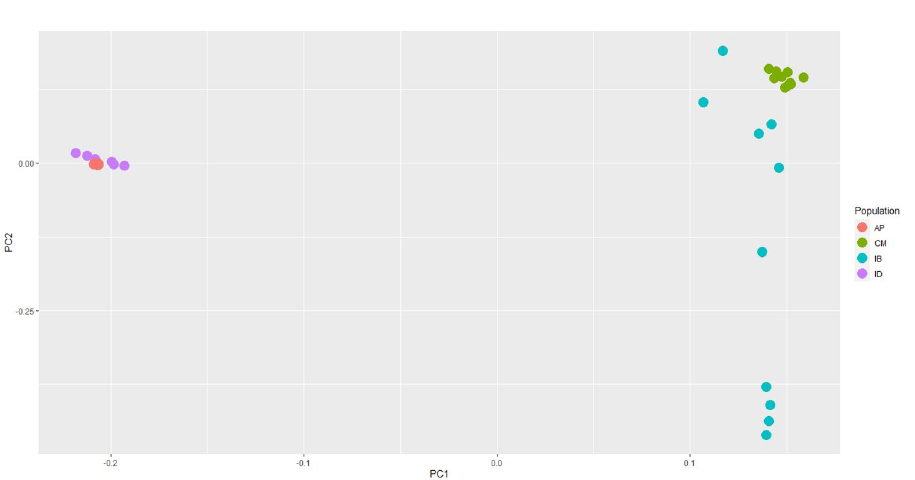
Figure 1. PCA plot visualized by R package ggplot2 (https:// cran.r- proje ct. org/ web/ packa ges/ ggplo t2); showing the two first PCs on all used dromedary and Bactrian camels in this